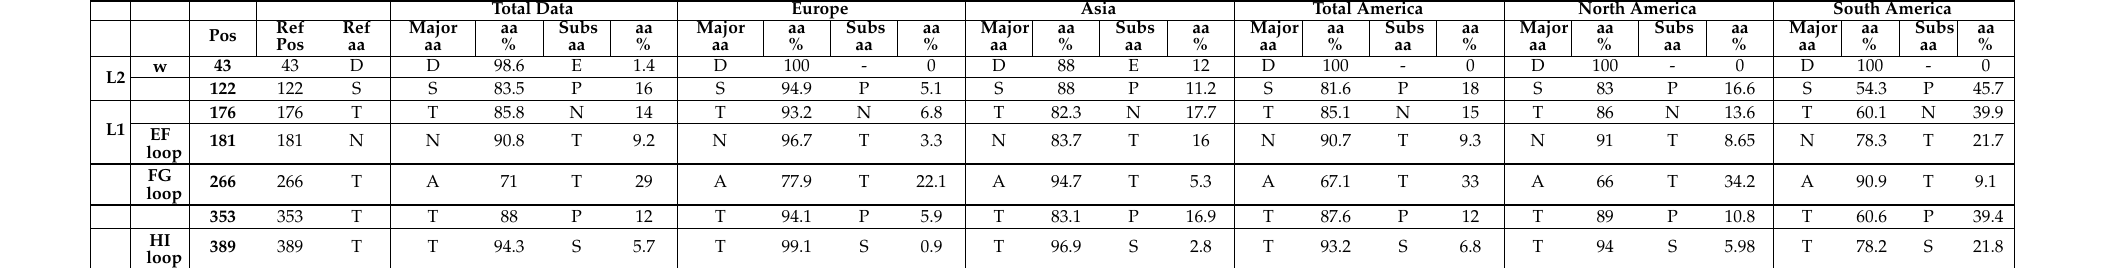
Table 2. Distribution of amino acid substitutions in the L1 and L2 proteins in various geographic